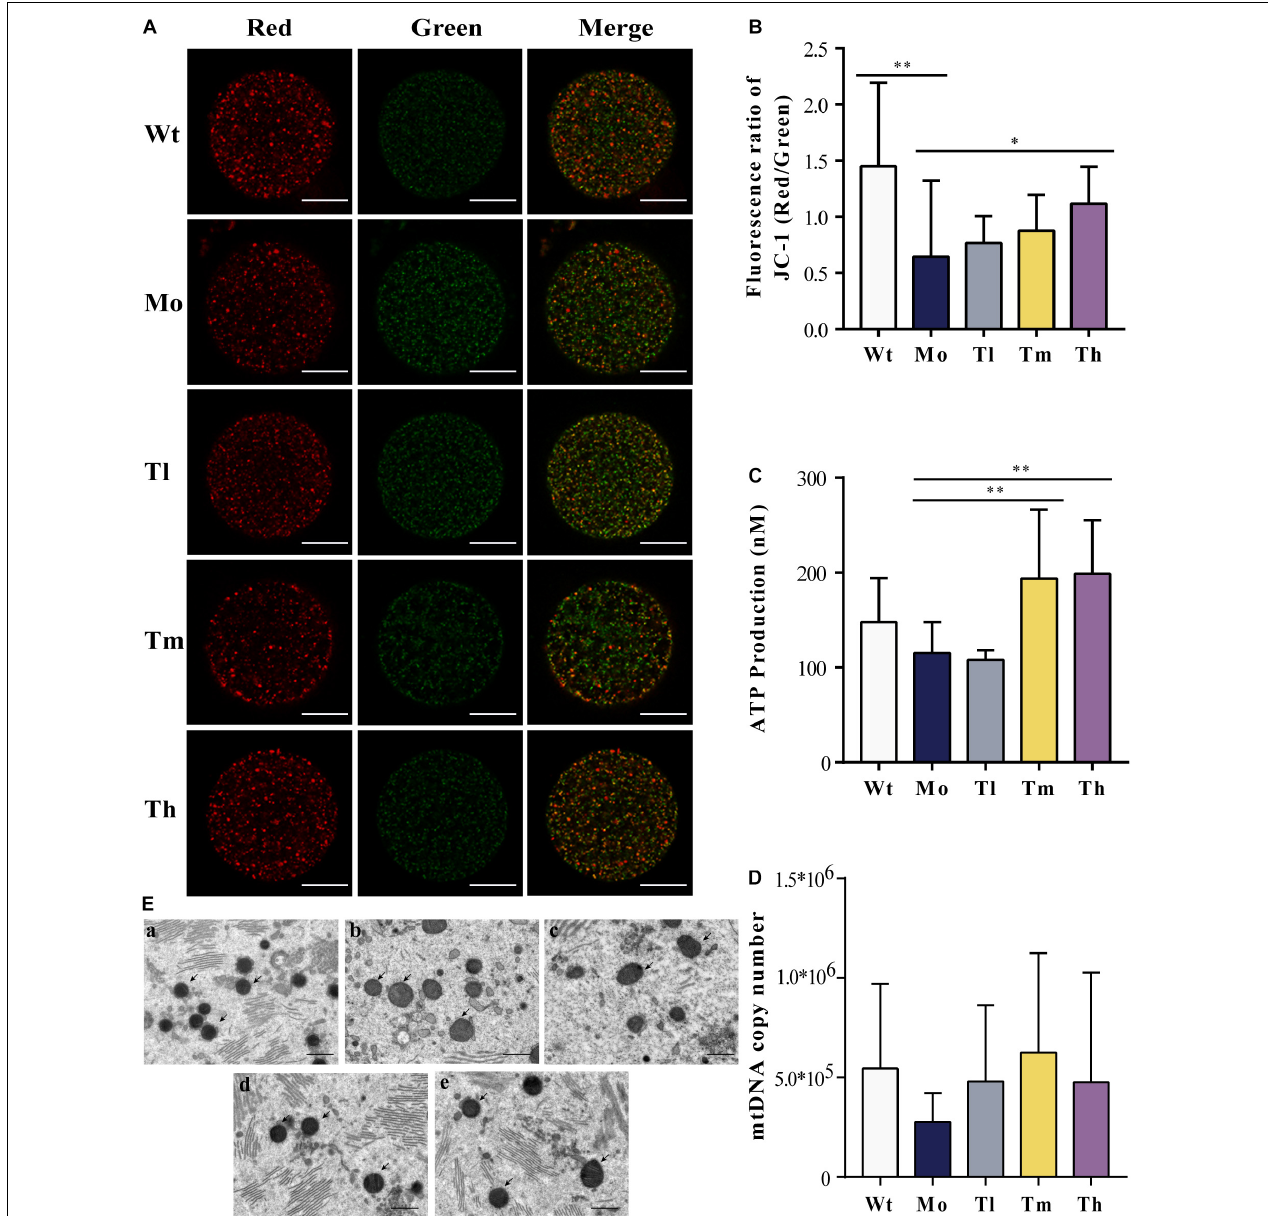
FIGURE 4 | Mitochondrial quality and energy metabolism. (A,B) Mitochondrial membrane potential quantification, where J-aggregates or monomers were indicated by red or green fluorescence ( n ≥ 10, ∗ P < 0.05, ∗∗ P < 0.01, scale bar = 25 µ m, × 40 magnification). (C) ATP content of each group ( n = 10, ∗∗ P < 0.01). (D) mtDNA copy number in each oocyte ( n = 10). (E) Mitochondrial status was evaluated under the electron microscope ( a, b, c, d, and e for the Wt, Mo, Tl, Tm, and Th groups, respectively. Black arrows pointed to mitochondria. n = 8, scale bar = 10 µ m, × 5,000